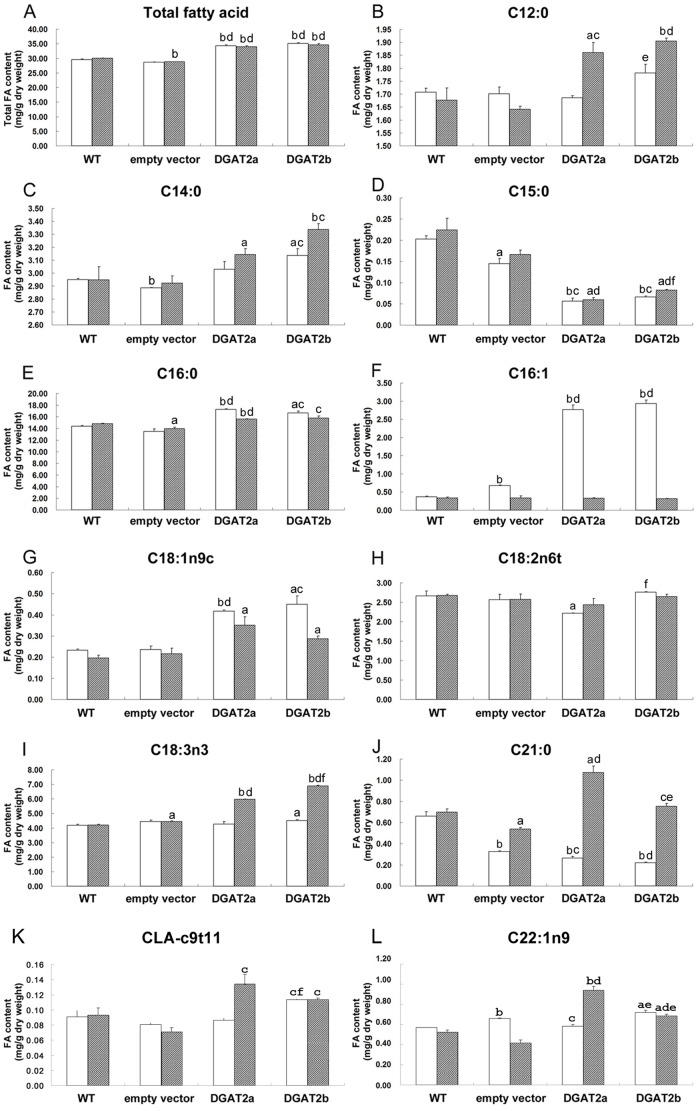
Fatty-acid content of wild-type E. coli strains and strains transformed with empty vector, AhDGAT2a–GST, and AhDAGT2b–GST.Open columns represent the values in un-induced strains and filled columns the values in IPTG-induced cultures after 6 h. Vertical bars represent the standard deviations of three replicates. a,c,e, significant at the 0.05 level; b,d,f, significant at the 0.01 level. a and b, compared with WT; c and d, compared with the empty-vector strain; e and f, compared with AhDGAT2a-GST vector strain. P values are given in Table S1.